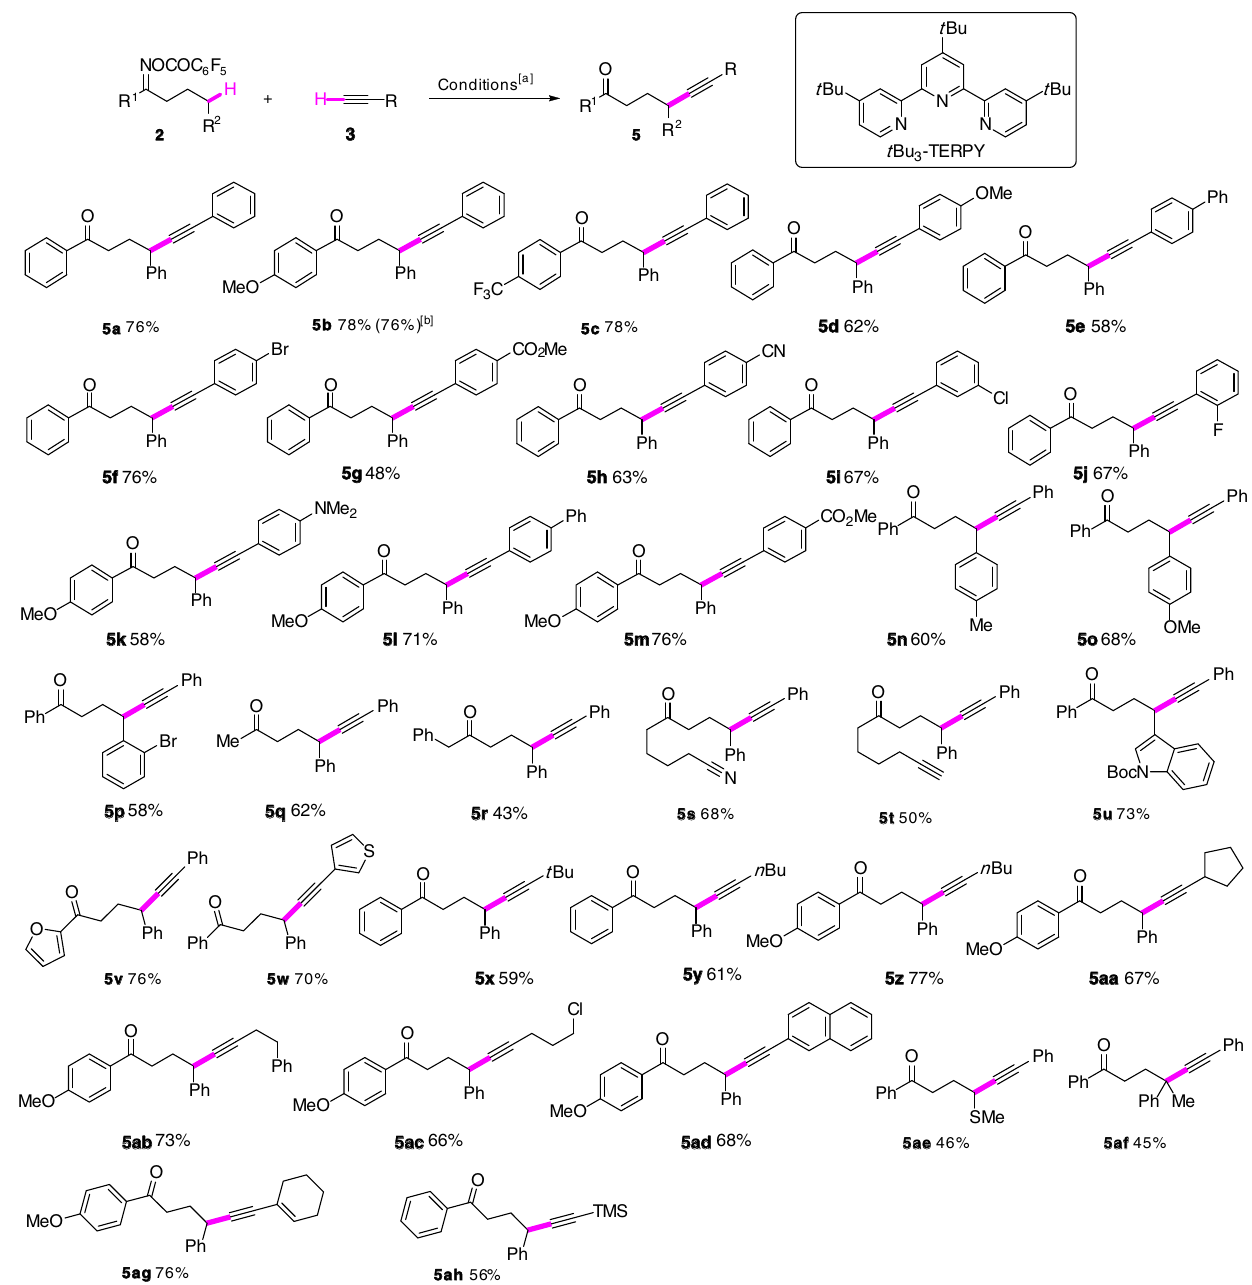
Fig. 4 Cu-catalyzed γ -C(sp 3 )-H alkynylation of linear oxime esters. [a] Conditions: 2 (0.1 mmol), 3 (0.2 mmol, 2.0 equiv), (CuOTf) 2 ·C 6 H 6 (0.05 equiv), t Bu c 0.05 M), 45 °C, under nitrogen atmosphere. Yields refer to the isolated products. [b] Reaction 3 -TERPY (0.1 equiv), K 2 CO 3 (2.0 equiv), DCE (2.0 mL, performed at 1.0 mmol